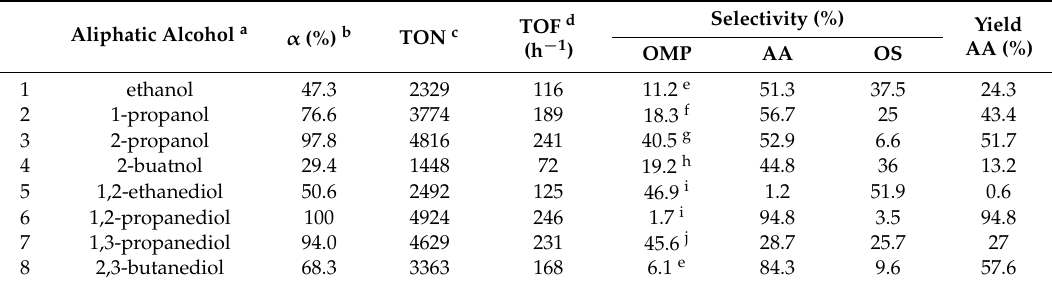
Table 5. Summary of the catalytic oxidation of various structurally different monohydric and dihydric aliphatic alcohols into acetic acid in the presence of the 0.1% Au/SiO 2 catalyst under reaction conditions as described in Section